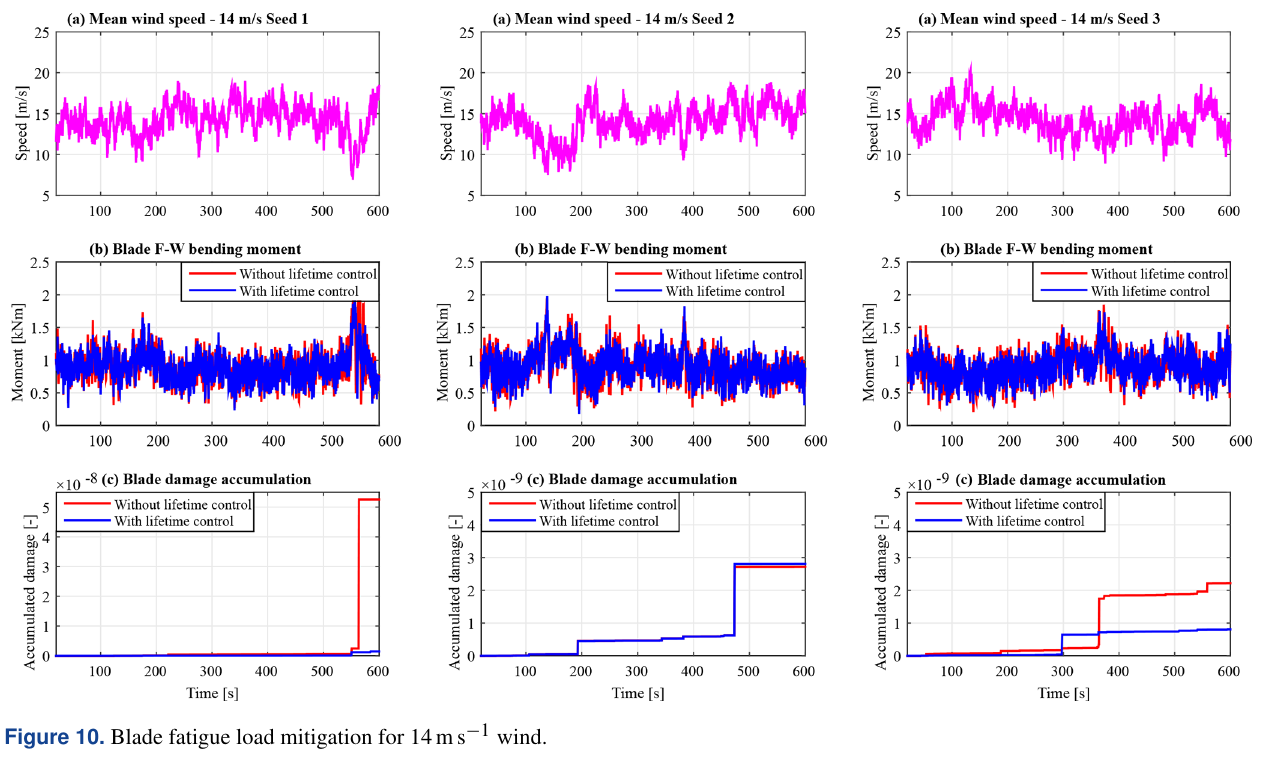
Figure 10. Blade fatigue load mitigation for 14ms − 1 wind.